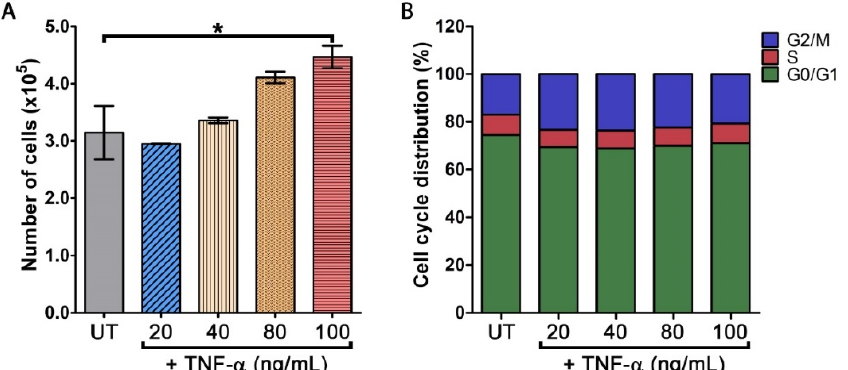
Figure 1. Effects of TNF- α on the proliferation and cell cycle distribution of human keratinocyte, HaCaT. ( A ) Number of HaCaT cells treated with different concentrations of TNF- α (20, 40, 80, and 100 ng/mL) (UT = untreated cells) for 48 h assayed by direct cell counting. ( B ) Cell cycle distribution of TNF- α -stimulated HaCaT cells at 48 h. * p < 0.05 in comparison to the untreated group.